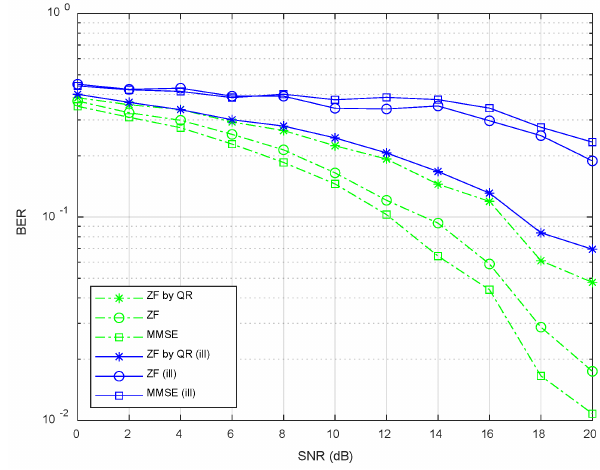
Figure 9. The effect of channel conditions on scheme performance.